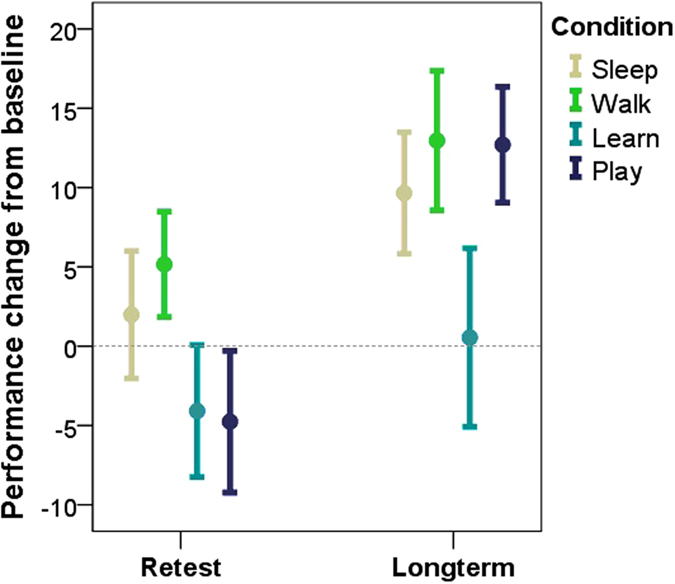
The differential learning patterns in the four retention interval conditions are revealed in subjects’ performance change (mean ± SE) at the Retest and Long-term occasions compared to Baseline.Values >0 indicate a performance improvement at the given occasion, while values <0 indicate a decreased performance.